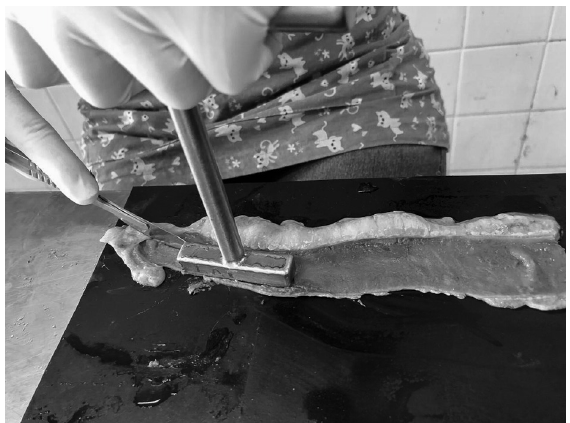
Figure 2. Jejunum sample collected in the longitudinal direction in an embalmed cats’